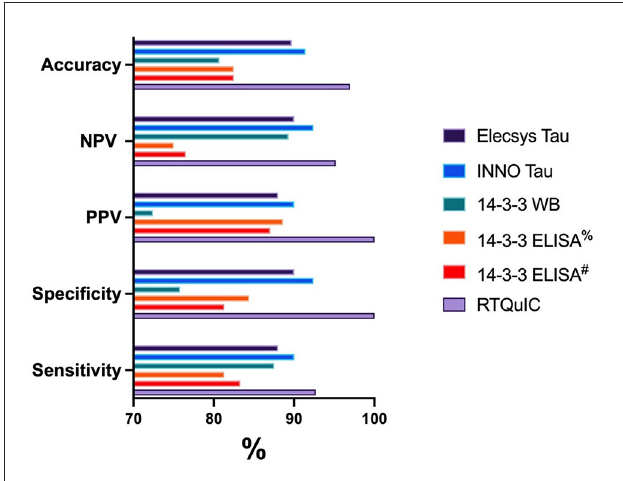
FIGURE1 Graphical representation of the diagnostic performance for each biomarker test. % 14-3-3 ELISA results based on ROC analysis 23194AU. # 14-3-3 ELISA results based on the previously published cutoff of 20000AU (33).